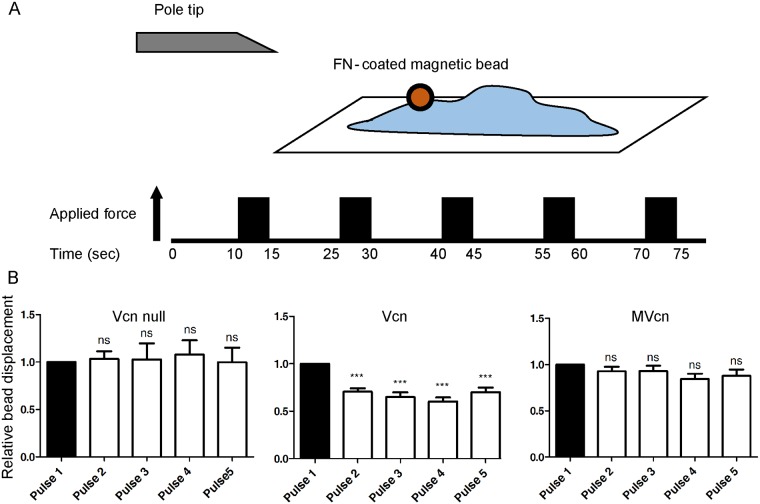
3D-Force microscopy (3DFM) shows reduced ability of MVcn-expressing cells to rescue cell stiffening response compared to Vcn-expressing cells.(A) 3D-force microscopy (3DFM) setup used to measure cell stiffening response. Constant force was applied for 5 sec intervals followed by 10 sec relaxation; this pattern was repeated for a total of 5 pulses. (B) Cell stiffening response is measured by quantifying the decrease in bead displacement after each subsequent pulse of magnetic force in Vcn-null, Vcn-, and MVcn-expressing cells. Cell stiffening response is lost in MVcn-expressing cells. Data pooled from 3 independent experiments (n ≥19 cells each cell type; ***, p<0.001).